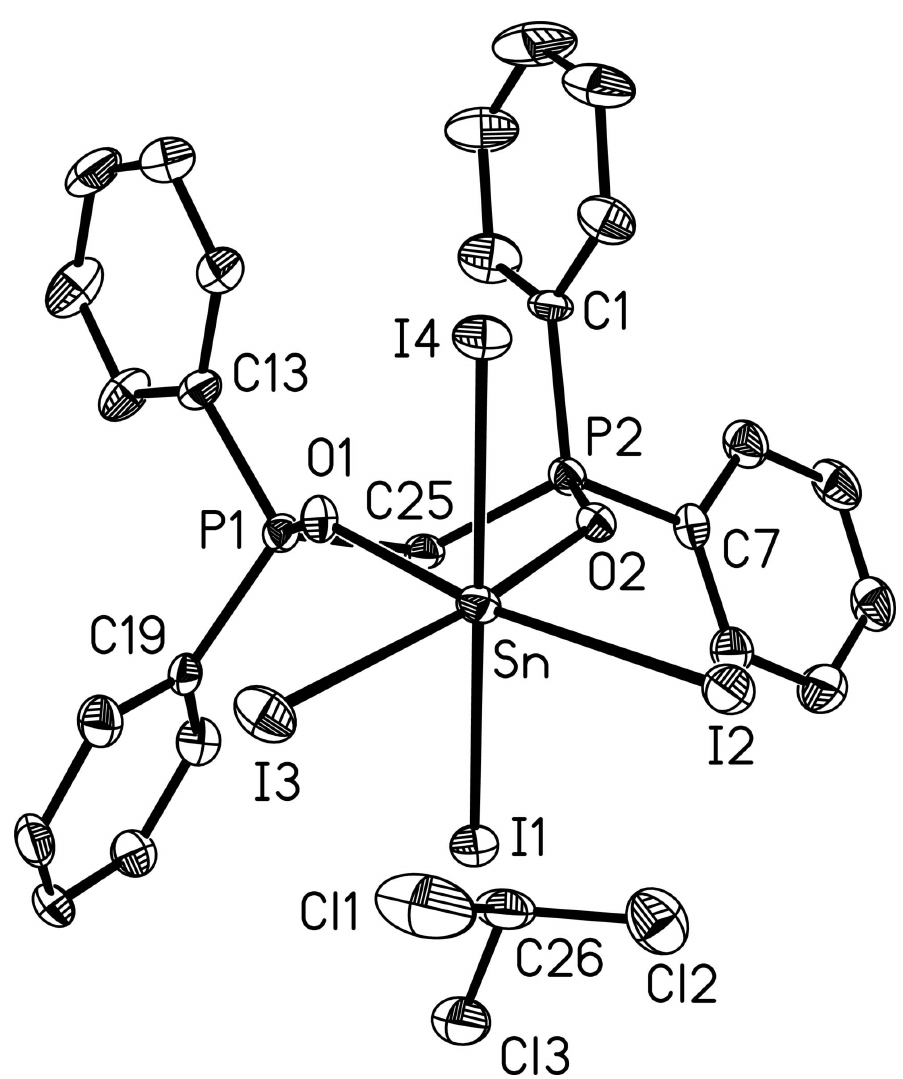
A view of complex (I) with displacement ellipsoids shown at the 50% probability level. H atoms have been omitted for